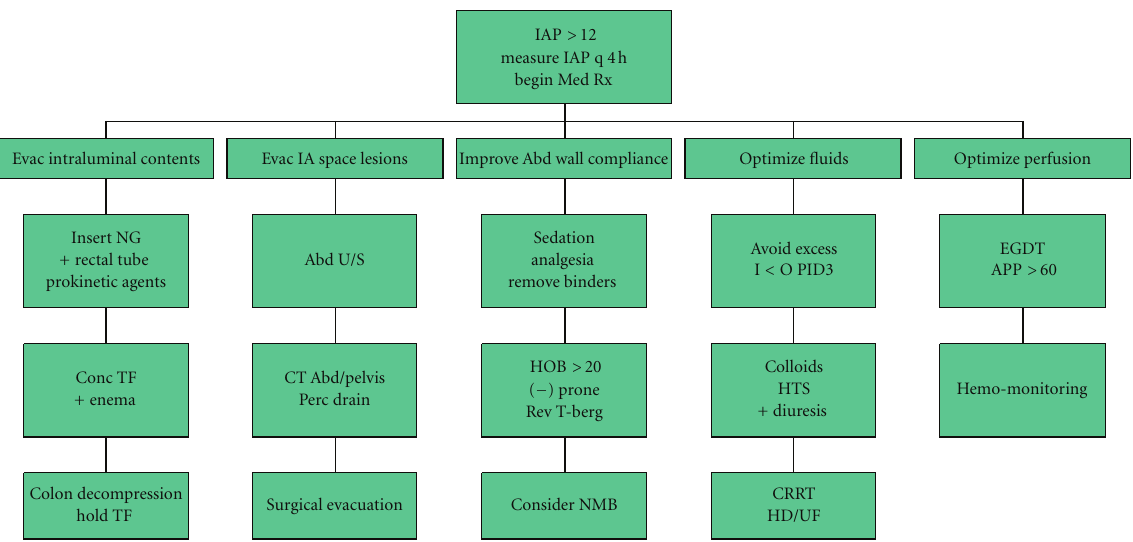
Figure 1: A tiered approach to IAH management (adapted from [16,